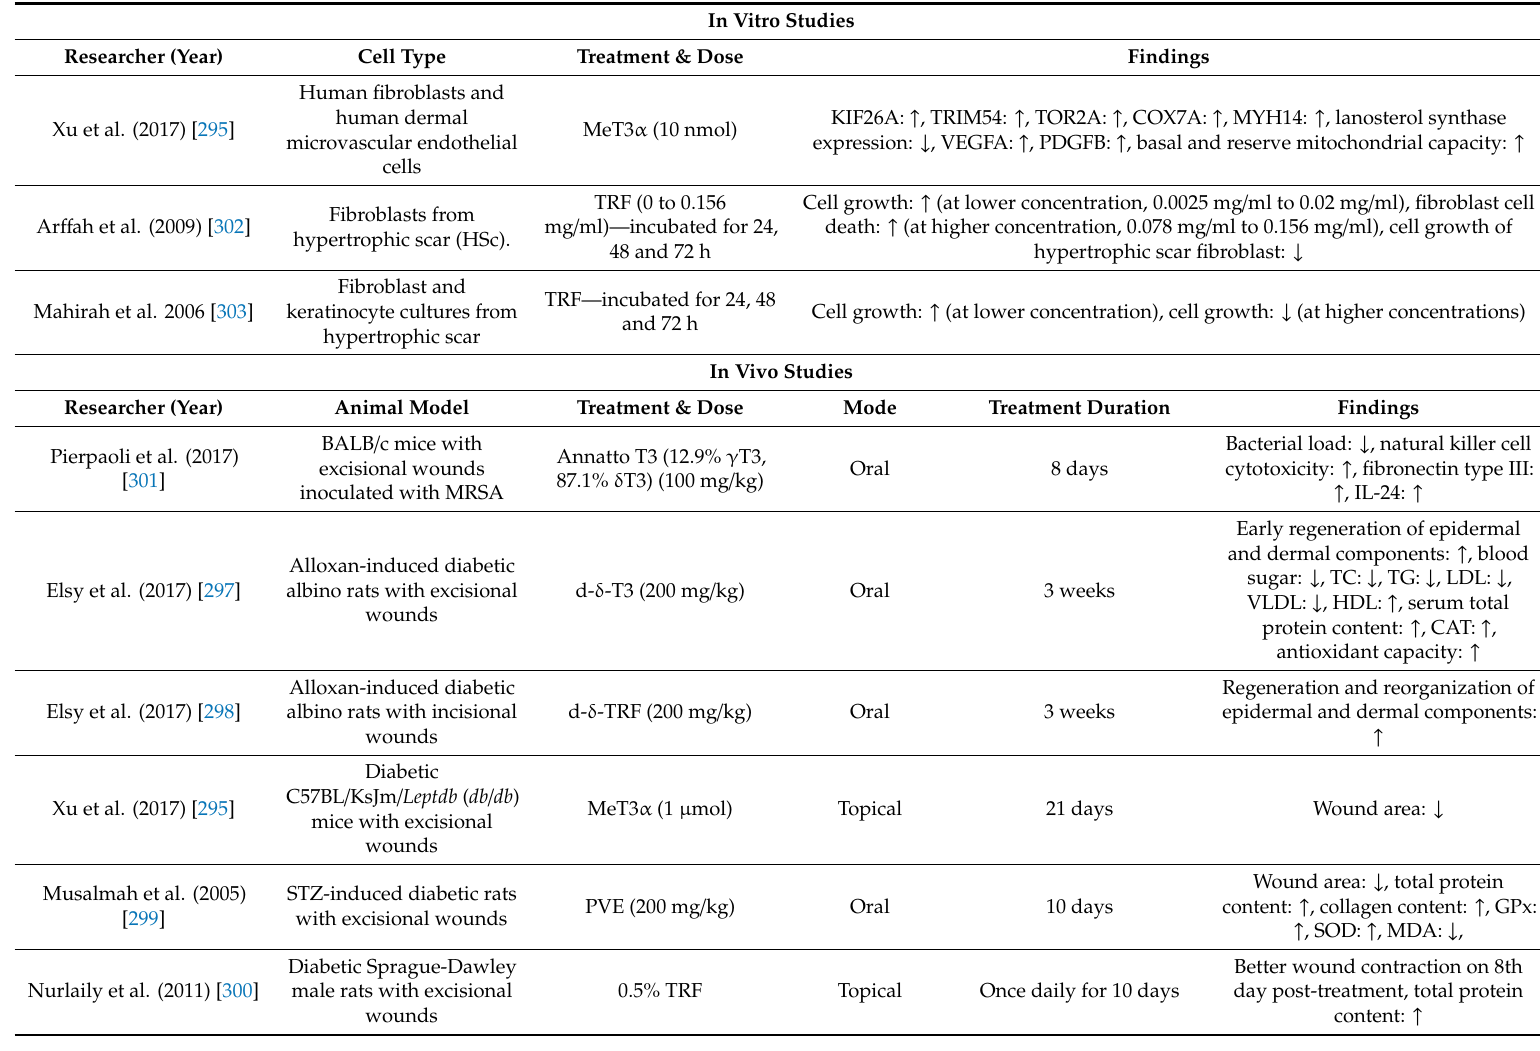
Table 14. E ff ect of T3 on wound